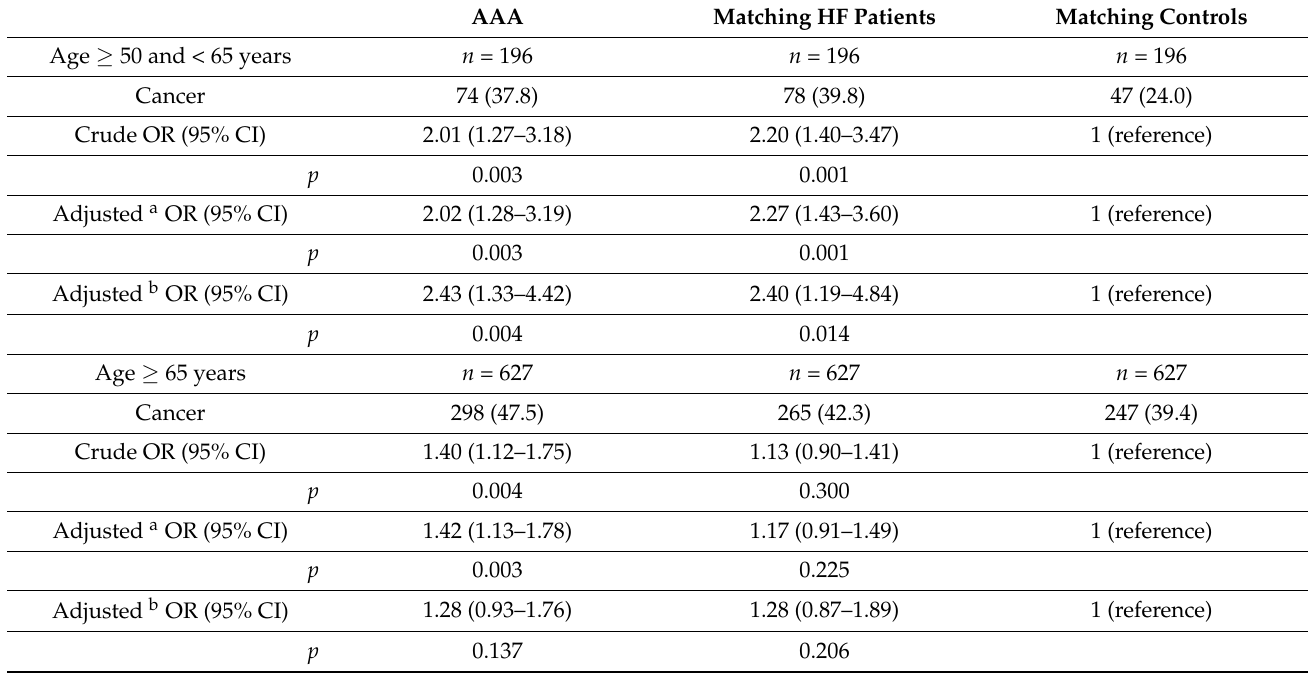
Table 3. Cancer risk stratified by age groups ( ≥ 50 and < 65 years and ≥ 65 years).